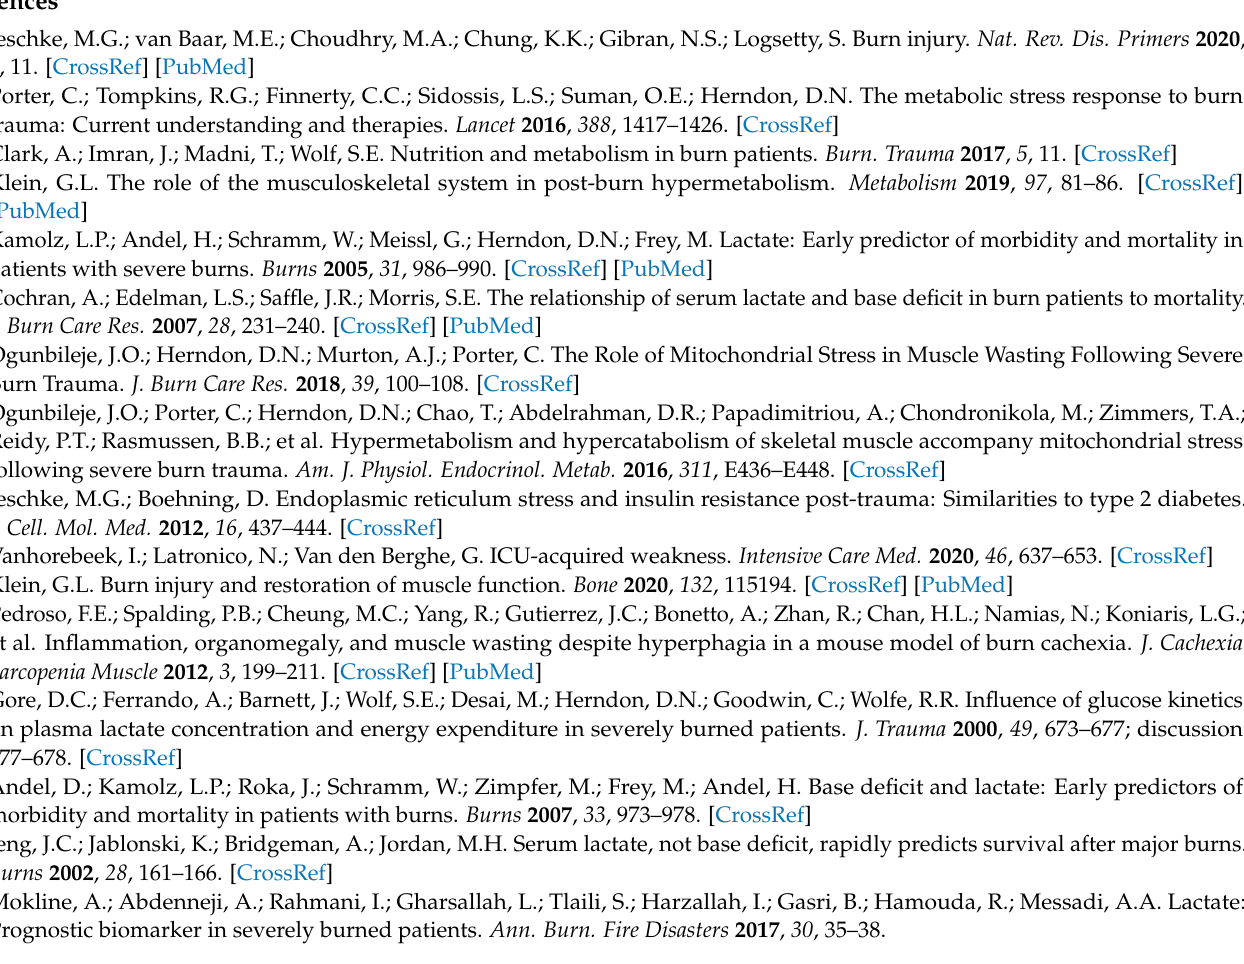
differential metabolites. Figure S3: Purine metabolism. Figure S4: Effects of burn injury and FTI-277 on metabolites related to purine metabolism. Figure S5: Urea/Ornithine cycle. Figure S6: Effects of burn injury and FTI-277 on phosphocreatine levels. Figure S7: Effects of burn injury and FTI-277 on amino acids levels. Figure S8: Effects of burn injury and FTI-277 on glycolysis intermediates. Figure S9: TCA